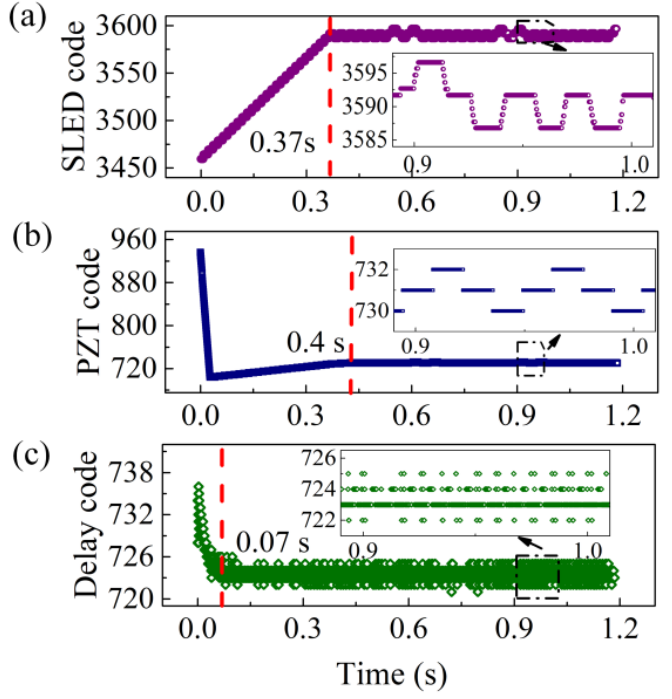
Figure 6. Dynamic control results of ( a ) SLED, ( b ) PZT, and ( c ) sampling delay during the startup